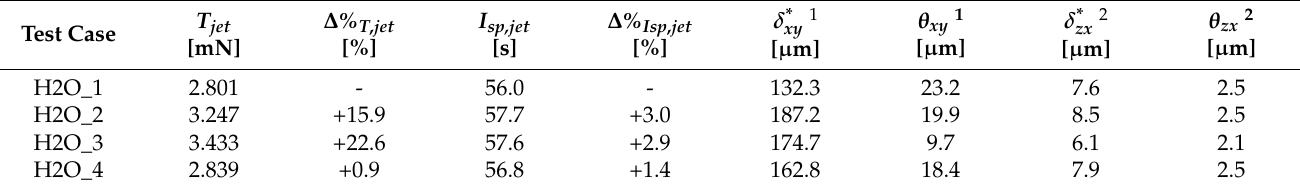
1 boundary layer thicknesses along the width-wise direction at the exit section in the symmetry plane (0, x,y ). 2 boundary layer thicknesses along the depth-wise direction at the exit section in the symmetry the plane (0, z,x